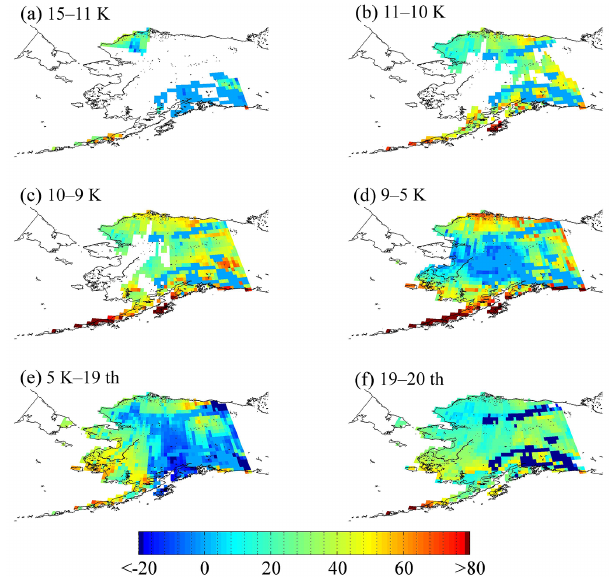
Figure 8. Peatland area expansion and peat soil C accumulation per 1000 years (kgCm − 2 kyr − 1 ) during (a) 15–11ka, (b) 11–10ka, (c) 10–9ka, (d) 9–5ka, (e) 5ka–1900AD, and (f) 1900–2000AD. The amount of C represents the C accumulation as the difference between the peat C amount in the final year and the first year in each time slice. The period of 9k–19th in Fig. 2d is separated into 9–5k and 5k–19th.